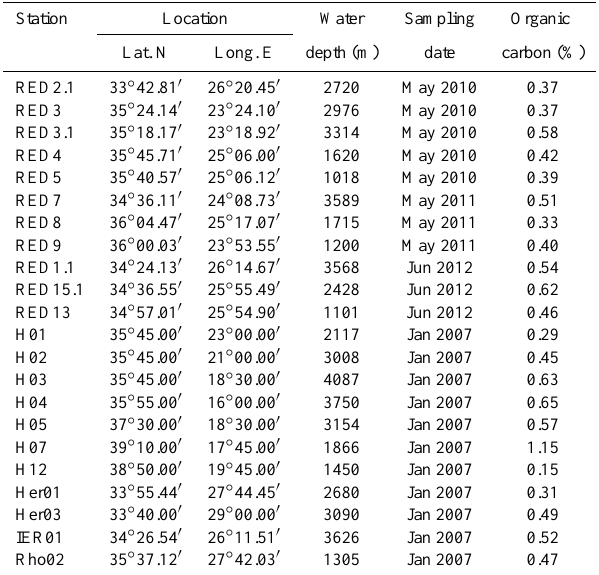
Table 1. Location and characteristics of sampling